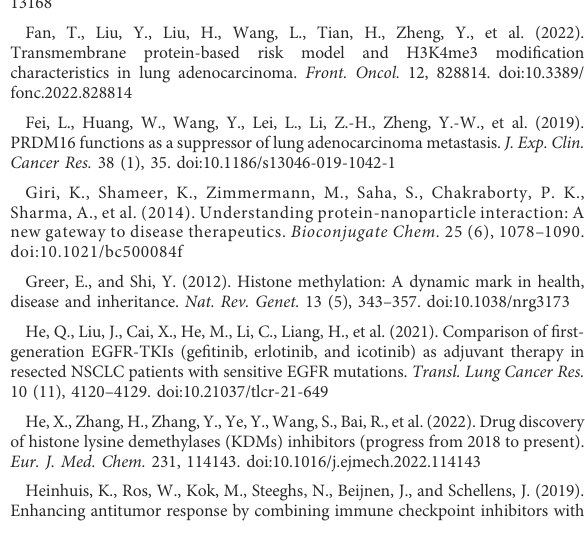
SUPPLEMENTARY FIGURE S1 Theheatmapandtheclinicopathologiccharacteristicsofthetwoclusters classi fi ed by these HMMRs. SUPPLEMENTARY FIGURE S2 The Kaplan-Meier curves for the 13 intersection genes. SUPPLEMENTARY FIGURE S3 Connections between tumor subtypes and risk subgroups.